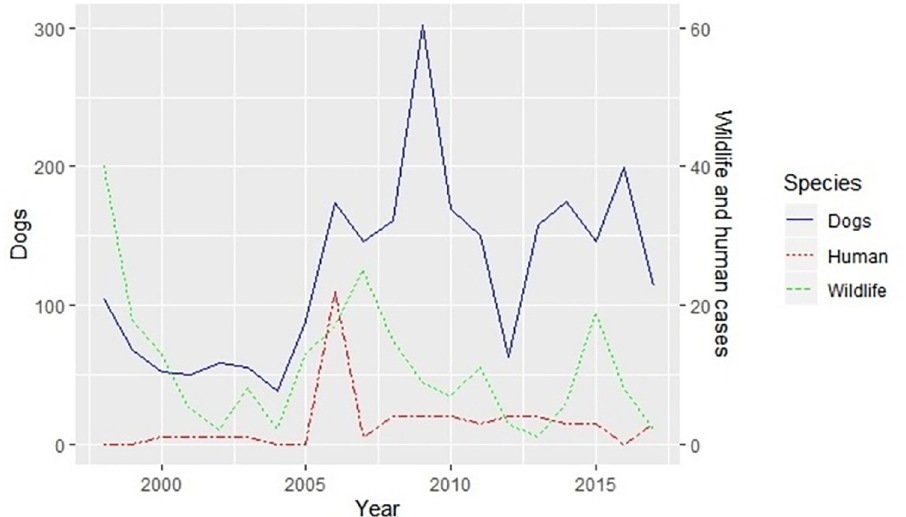
Fig 3. Temporal dynamics of human, dog, and wildlife rabies cases in northern South Africa between 1998 and 2017.